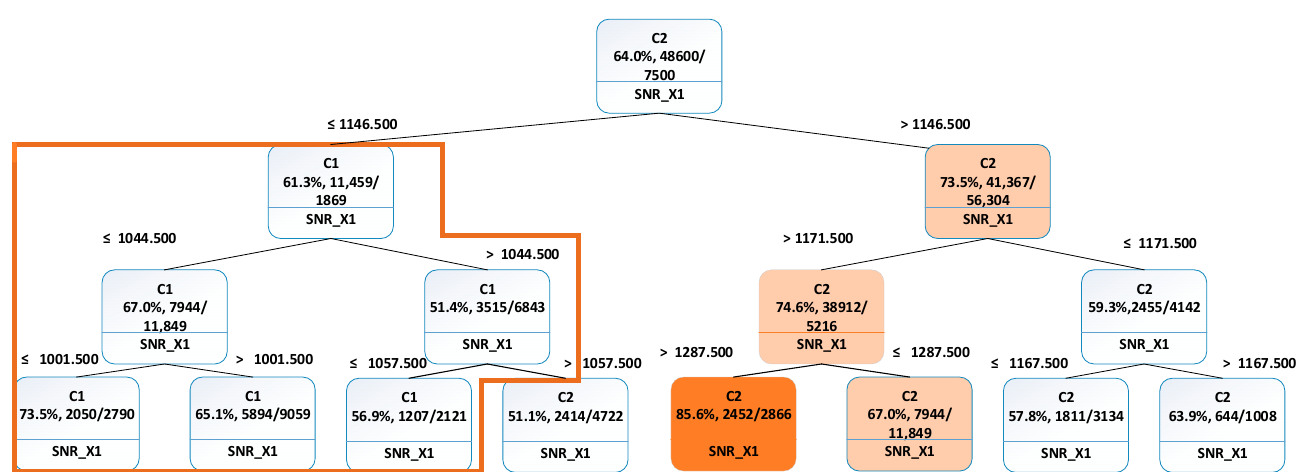
Figure 8. Classification decision tree of two clusters described by SNR_X1.